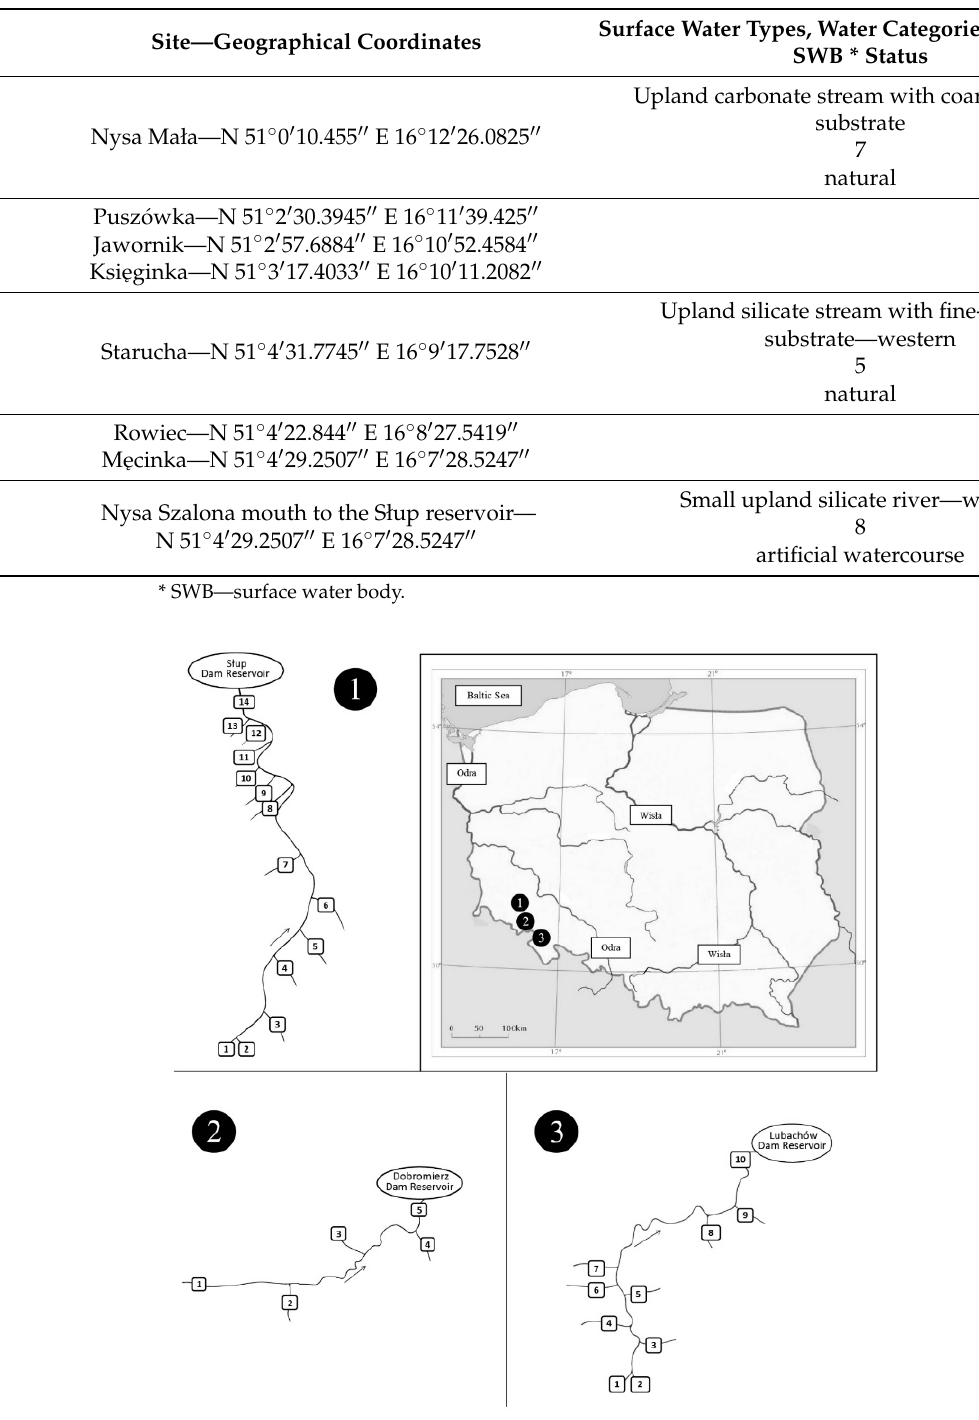
Figure 1. Location of the study area, 1—Słup reservoir—research sites on the Nysa Szalona River and its tributaries (Table 2), 2—Dobromierz reservoir—research sites on the Strzegomka River and its tributaries (Table 3), 3—Lubachów reservoir—research sites on the Bystrzyca River and its tributaries (Table 4). Table 2. Research sites—the Nysa Szalona River and its tributaries above the S ł up dam reservoir [19].